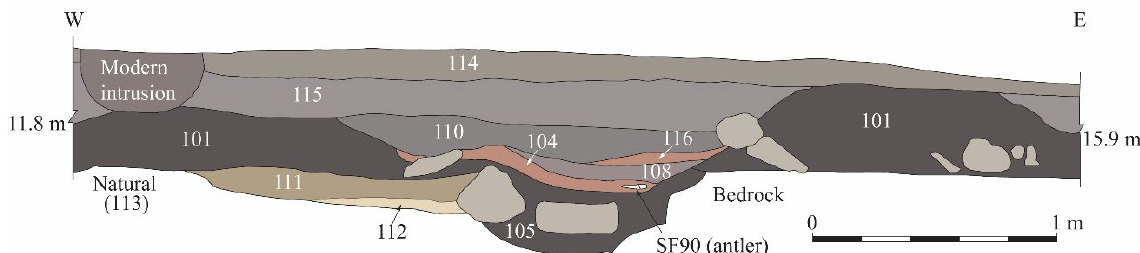
Figure 2. Stratigraphy of RPAS, showing a Mesolithic fireplace constructed between outcrops of bedrock. Content 114 is the topsoil below surface vegetation, which continues into Context 115 that contains disturbed Mesolithic artefacts or narrow blade tradition that we assign to technology Concept 2. Contexts 101 is an in situ Mesolithic occupation horizon that contains dense quantities of chipped stone artefacts of narrow blade affinity, that we designate as Concept 2, coarse stone tools, charred hazelnut shell, charcoal and fragmented bone. Contexts 110, 104, 116, 108 and 105 are horizons within a Mesolithic fireplace Context 111 contained a chipped stone assemblage with we designate as Concept 1 and attribute to the Ahensburgian. Context 112 is the sterile horizon, a glacial till. Table 1. Steps in the chaîne opératoire represented in RPAS Context 111, excavated 2013, and Contexts 115